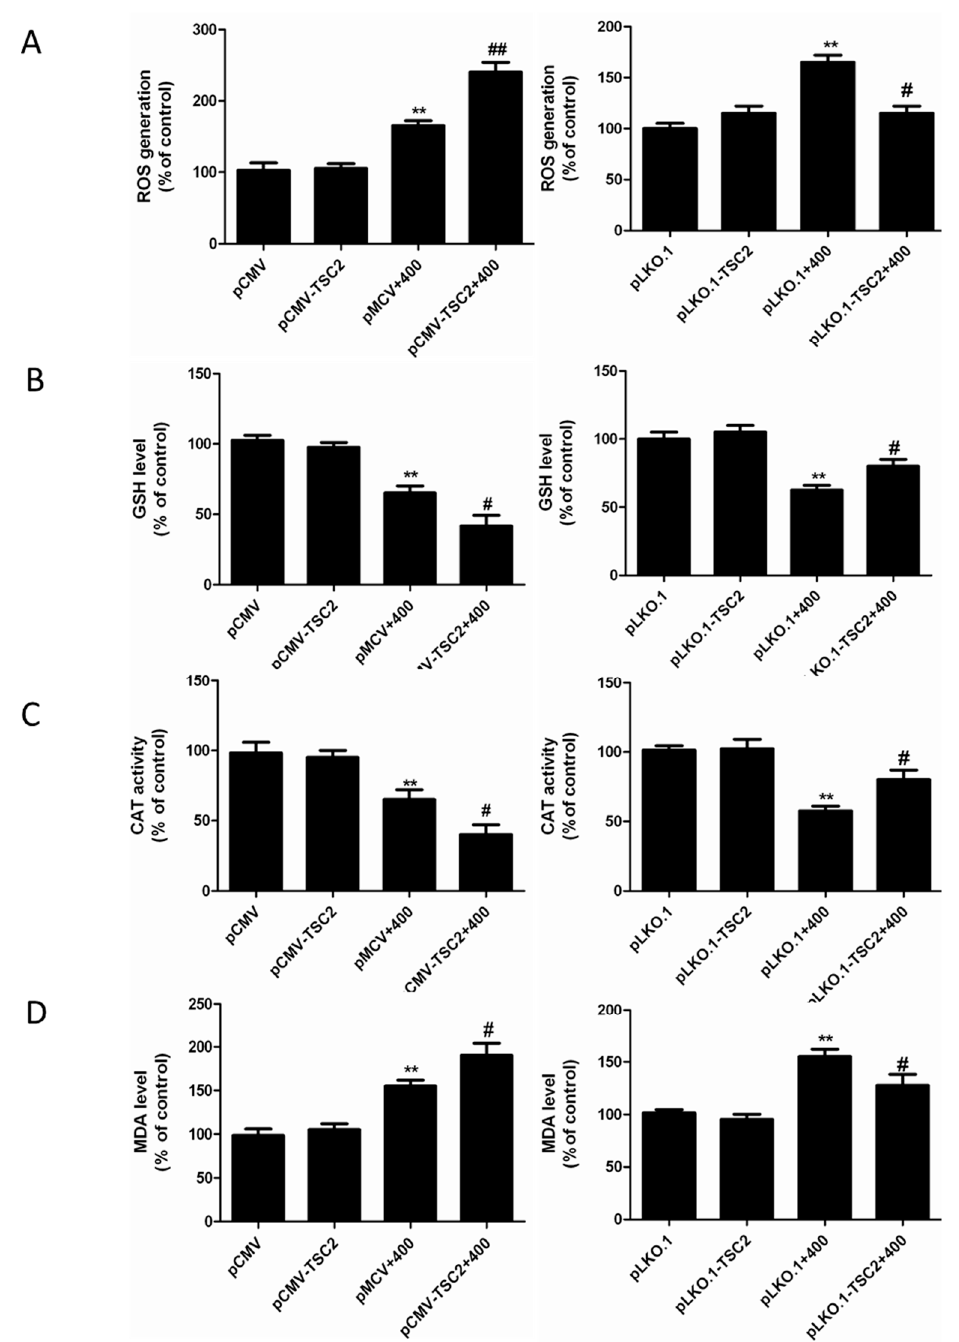
Figure 6. Effects of TSC2 on olaquindox-induced ROS generation and oxidative stress in HEK293 cells. ( A ) Intracellular ROS production was measured by 2,7-dichlorofluorescein diacetate (DCFH-DA) in TSC2 overexpressed and knockdown cells. ( B – D ) Effect of olaquindox treated on cellular glutathione (GSH) levels, catalase (CAT) activities and malondialdehyde levels (MDA) in TSC2 overexpressed and knockdown cells, respectively. ** p < 0.01, compared to the control pCMV or pLKO.1 transfected cells; # p < 0.05, ## p < 0.01, compared to olaquindox-treated pCMV or pLKO.1 transfected cells.